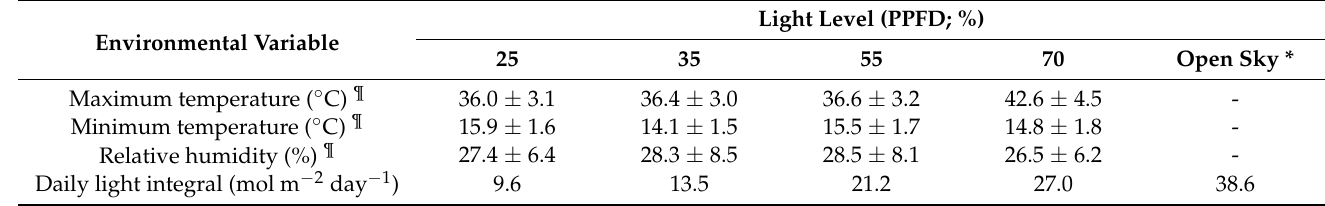
Table 5. Environmental conditions recorded in each light